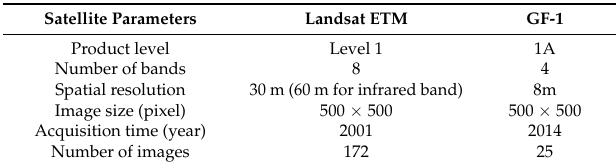
Table 2. Number of images with different cloud covers.